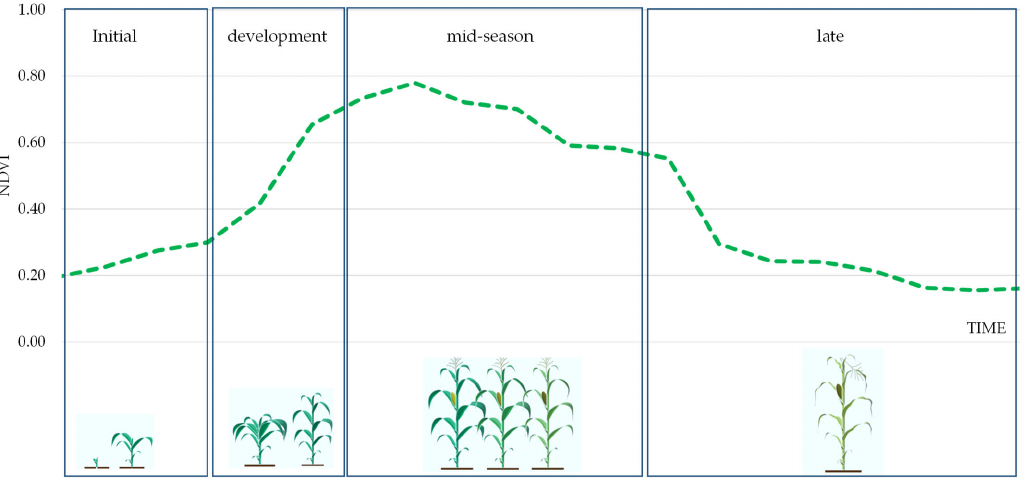
Figure 5. Phenological diagram of crops at different stages of development along with the NDVI profile.